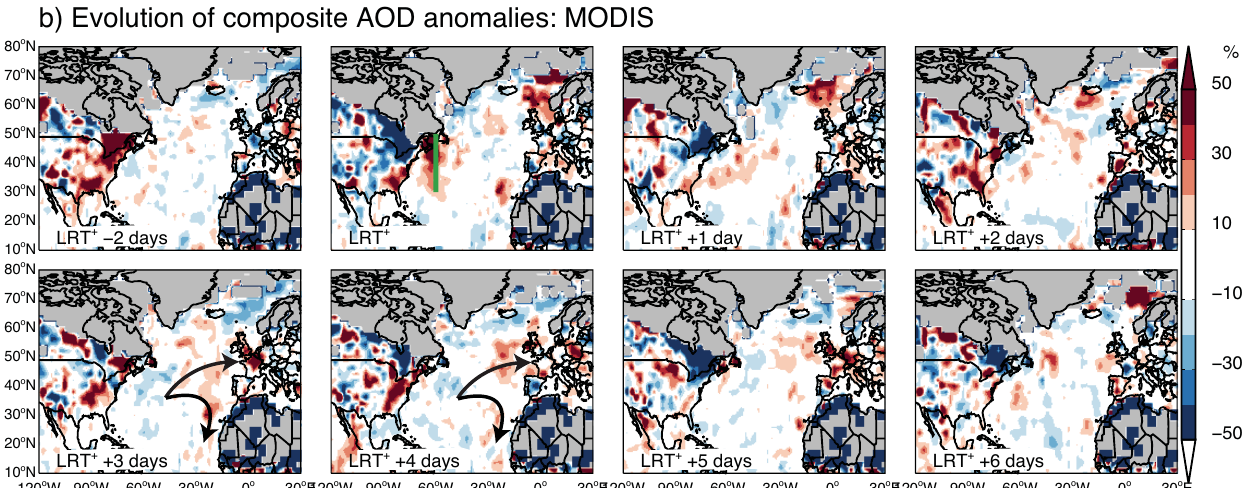
Fig. 10. Springtime evolution of AOD anomalies from 2 days prior to LRT + days to 6 days after LRT + days over the N. Atlantic. The AOD anomalies are expressed in percent relative to seasonal mean AOD values. (a) GEOS-Chem AOD anomalies. Arrow indicated composites of 850hPa wind fields. (b) MODIS AOD